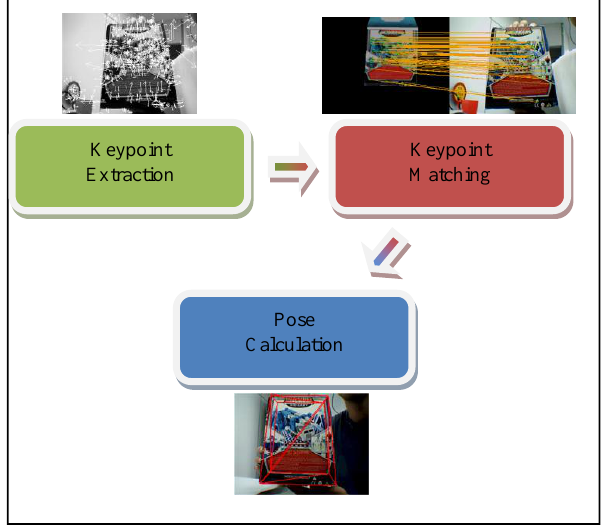
Figure 12. KB technique workflow